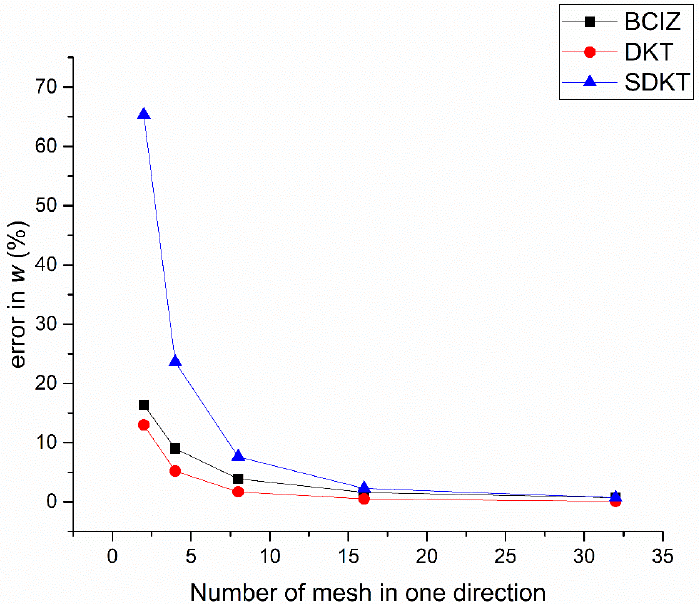
Figure 10. Error of the central deflection for a clamped square plate under center point load.